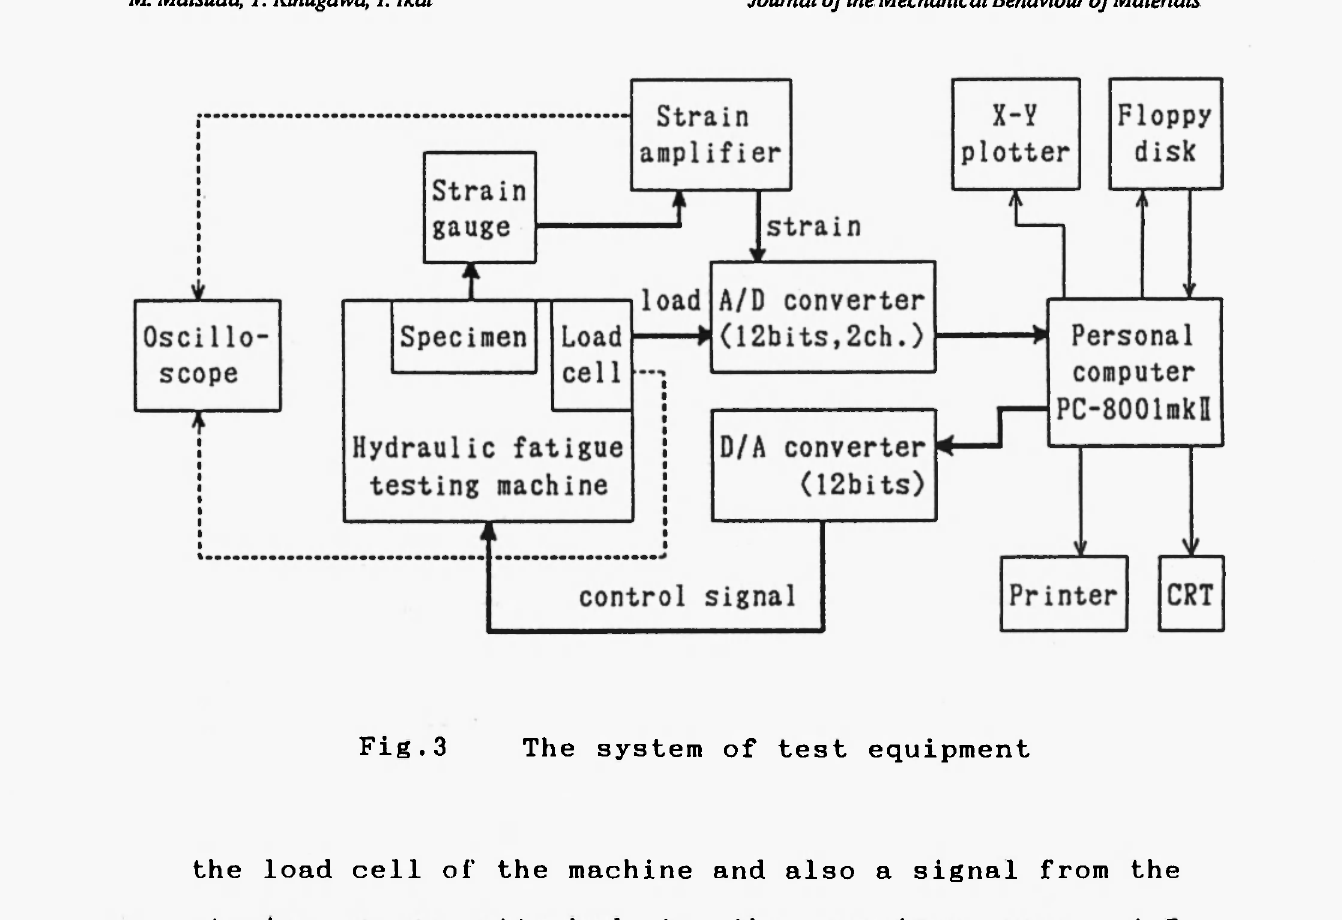
Fig.3 The system of test equipment